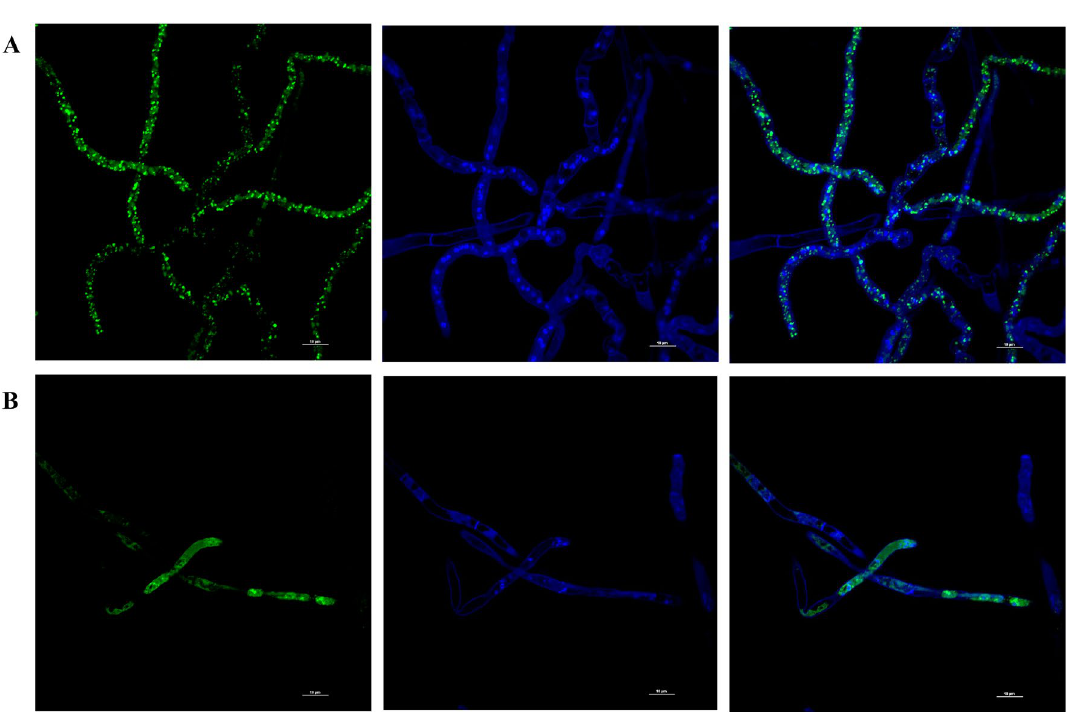
Figure 5. Mitochondrial staining of A. niger GM31 with MitoTracker Green before and after treatment with Argirium-SUNCs . From left to right (nucleus-mitochondrial-overlaped): fluorescence intensity of Hoechst (nucleus), MitoTracker Green (mitochondrial viability): ( A ) untreated hyphae and ( B ) treated hyphae with 0.625 mg L −1 of Argirium-SUNCs . Scale bar: 20